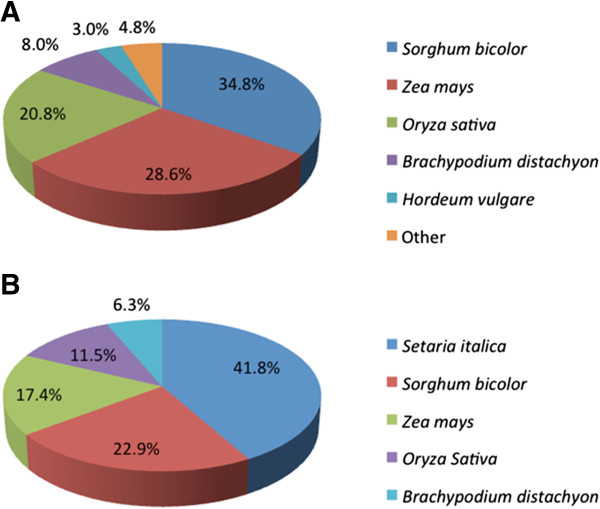
Species distribution of the top BLAST hits for the ‘Prestige’ sequences. Transcripts were compared to the NCBI nr database (A), and also to model Liliopsida plants from Ensembl (B).